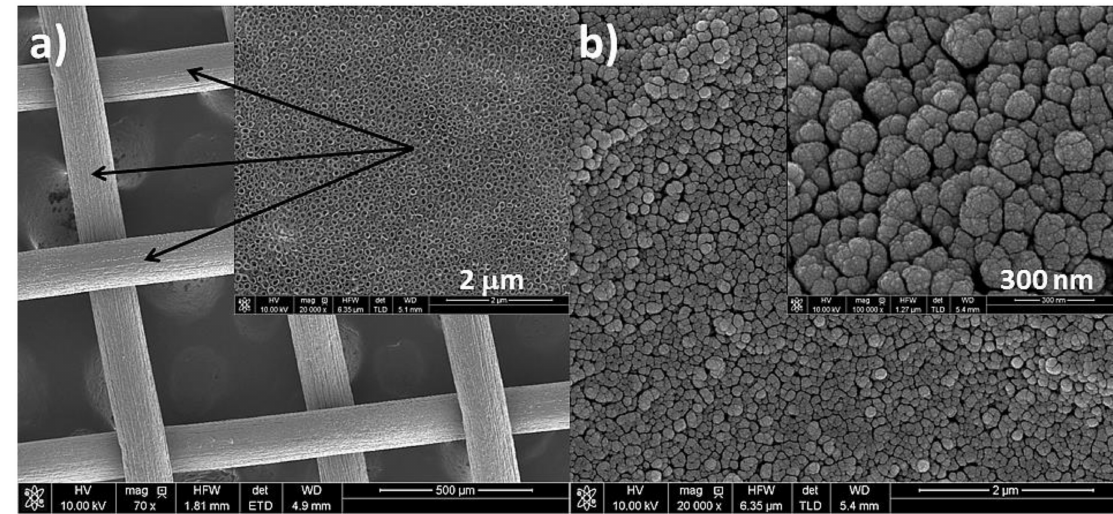
Figure 8. SEM images of a nanotubes formed at 25 V on Ti mesh, annealed at 450 ◦ C / 1 h ( a ) and covered with metal deposit: 0.2 mg cm − 2 Pd ( b